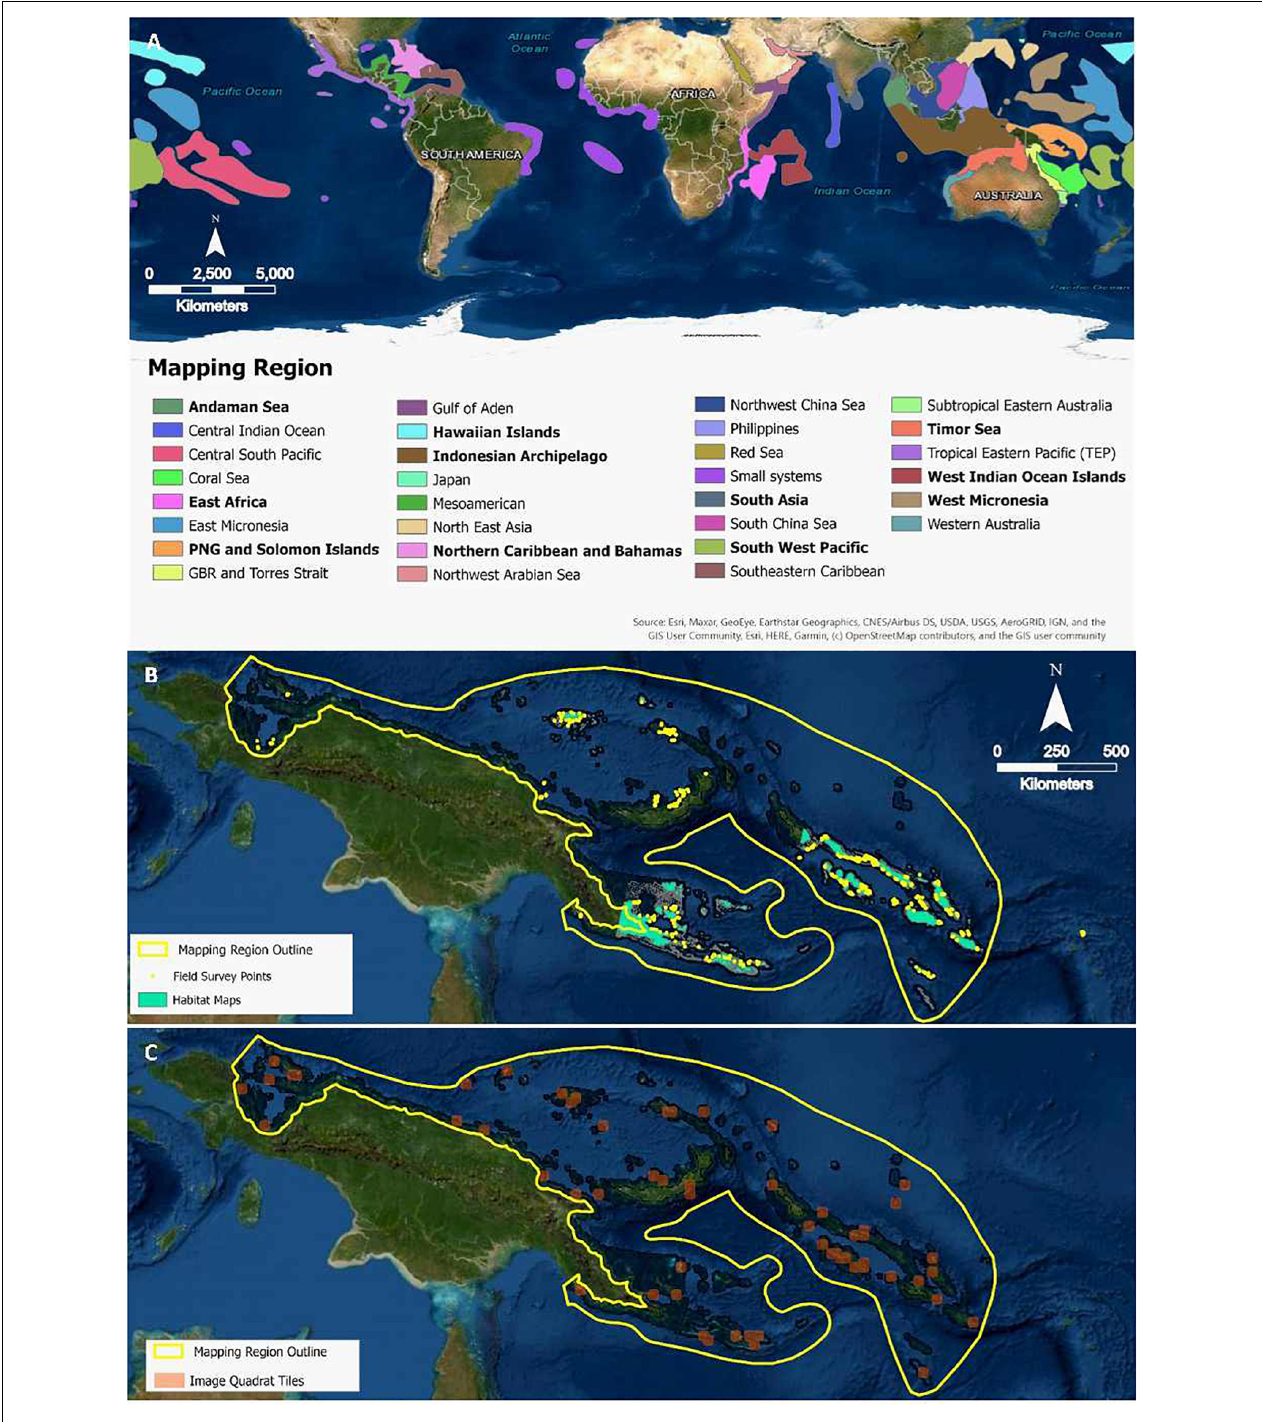
FIGURE 2 | Global reef mapping regions. (A) Division of the global reefs into similar biogeographic regions representing individual mapping regions. Regions completed as of December 2020 are indicated in bold type; (B) the distribution of existing field data and maps for the Papua New Guinea – Solomon Islands mapping region; and (C) Papua New Guinea – Solomon Islands region with the location of the reference data indicated (highlighted image quadrat tiles each of 20 km × 20